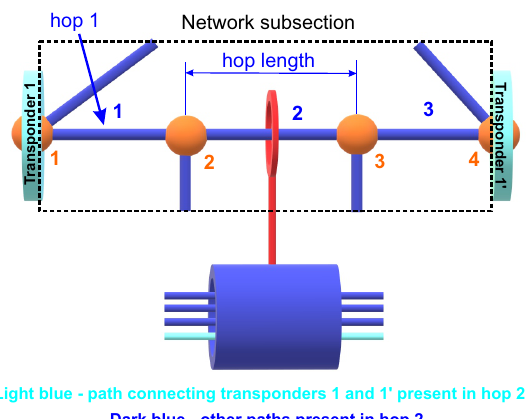
Figure 3. Network subsection illustrating the meaning of the specific channel attributes occurring in the studied